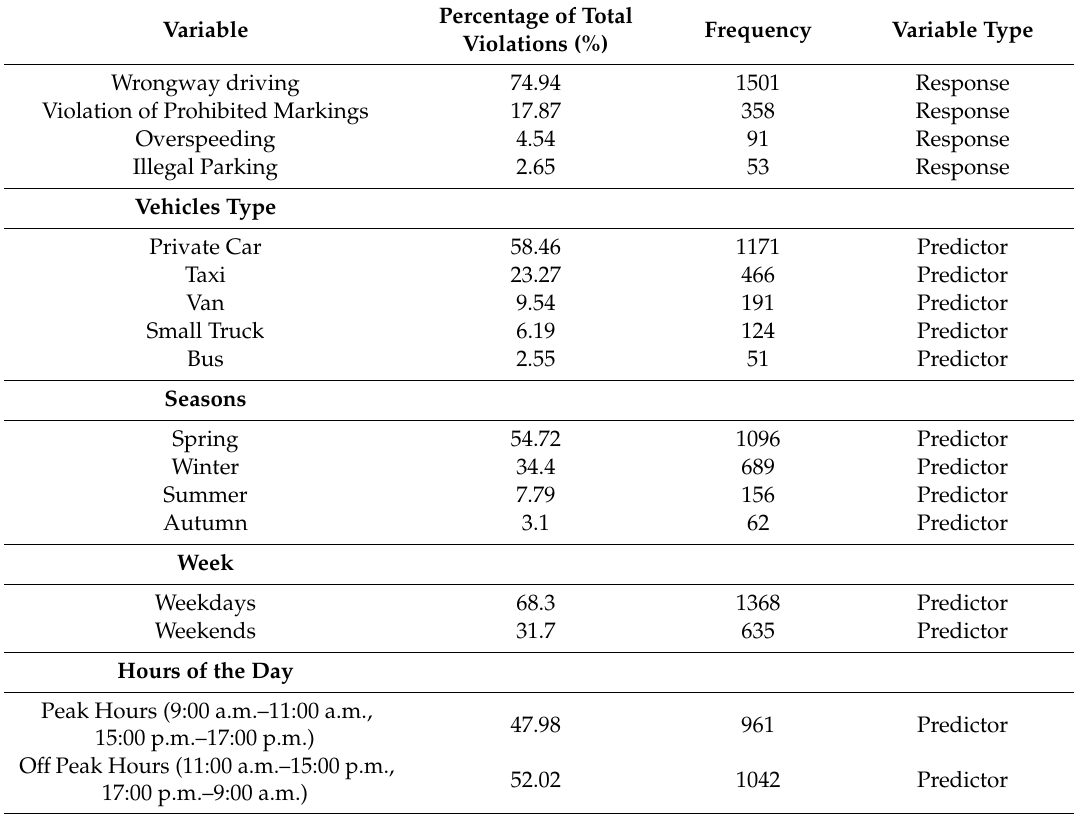
Table 3. Descriptive Statistics of Violations (N =